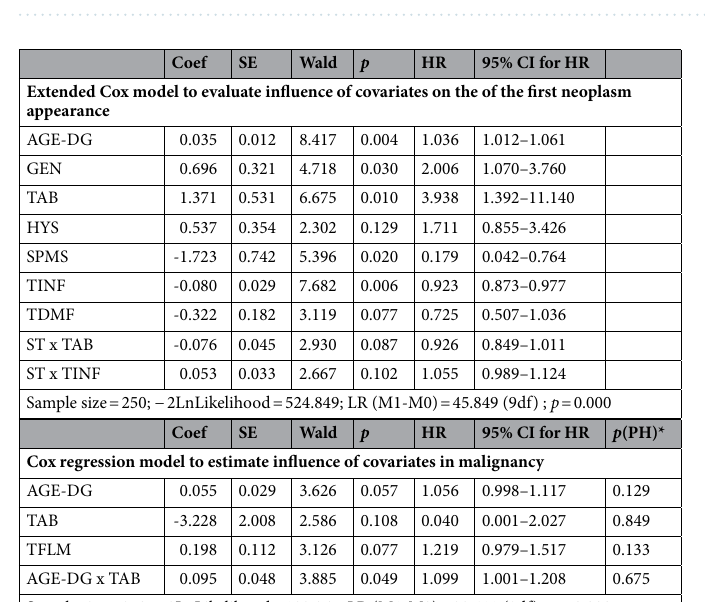
Figure 1. Drug prescription frequency in the therapeutic sequence. Percentages were calculated in relation to the group total cases.